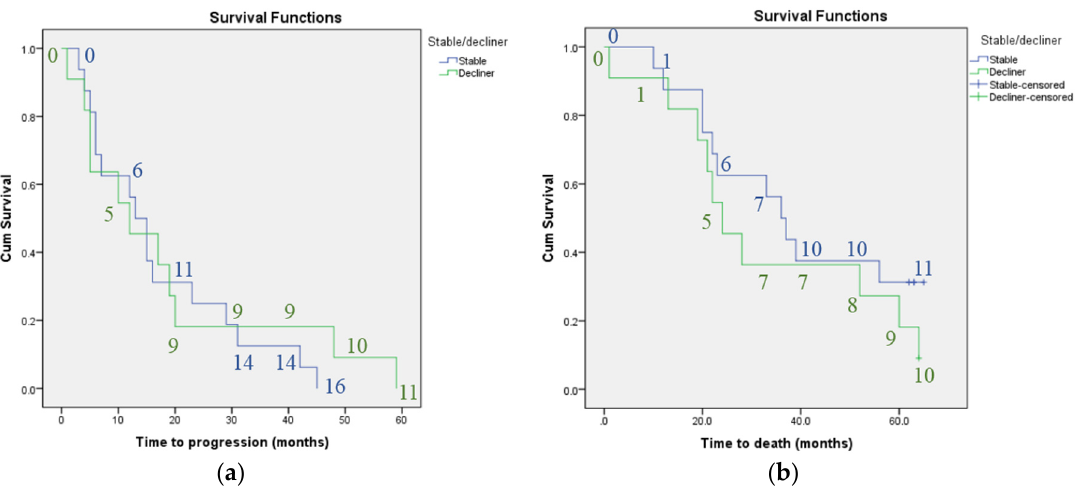
Figure 3. Kaplan-meier curves: survival in terms of: ( a ) disease progression and ( b ) mortality according to previous stable versus declining lung function; Kaplan-meier curves showing a non-significant trend towards shorter survival as measured by progression of lung disease or mortality in patients with previous declining versus stable lung function (over 6 or 12 months prior to recruitment to study).